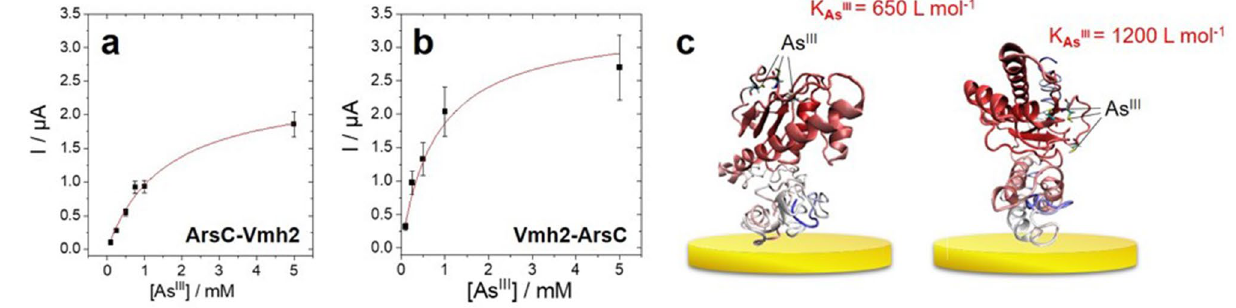
Figure 6. Evolution of the SWV peak current towards starting As(III) concentrations. ( a ) ArsC-Vmh2- modified gold electrode and ( b ) Vmh2-ArsC-modified gold electrodes accompanied by a schematic representation of arsenic binding ( c ). The red line corresponds to the curve fitting using Eq.